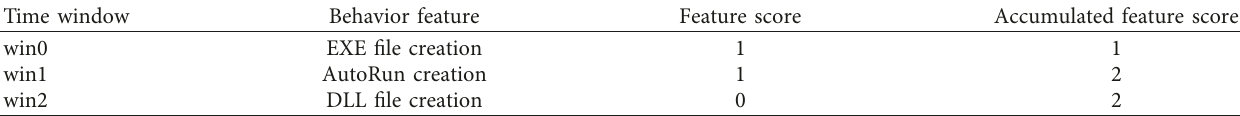
Table 8: Example of behavior vector of malicious process accumulation.